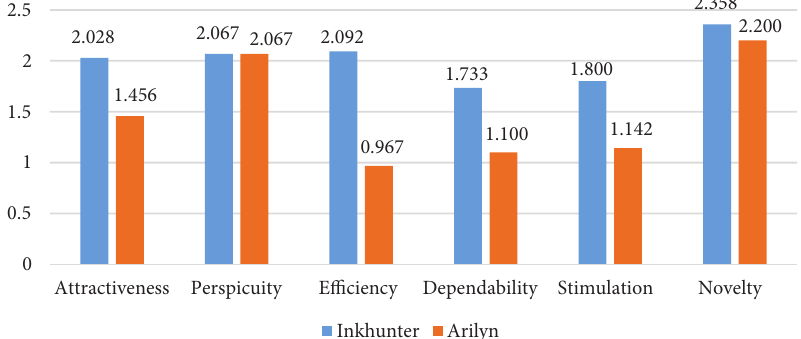
Figure 2. Evaluation of augmented reality applications Inkhunter and Arilyn according to the six dimensions (source: created by the